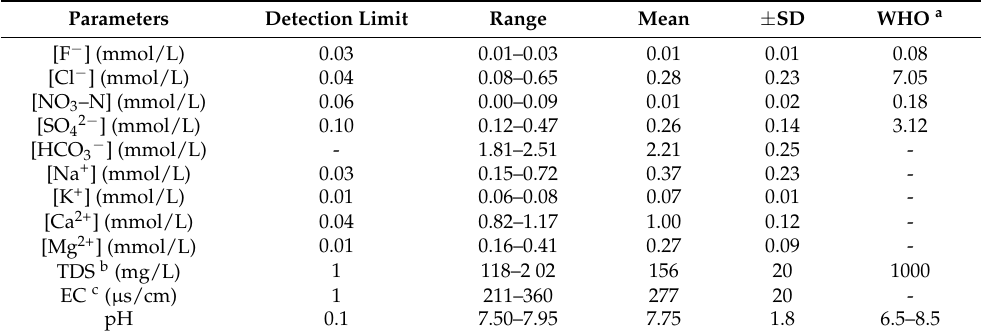
Table 1. The hydrochemical parameters in Xiaojiang River ( n =